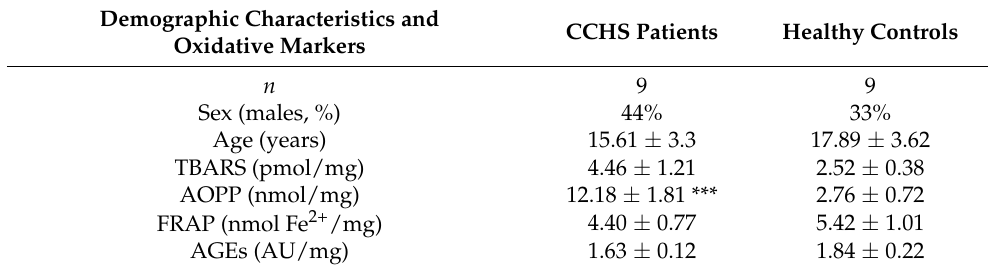
Table 2. Demographic features, and serum biomarkers in CCHS patients and healthy